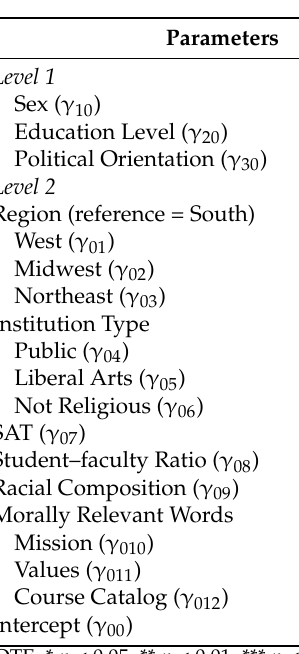
Table 2. Parameter estimates for target